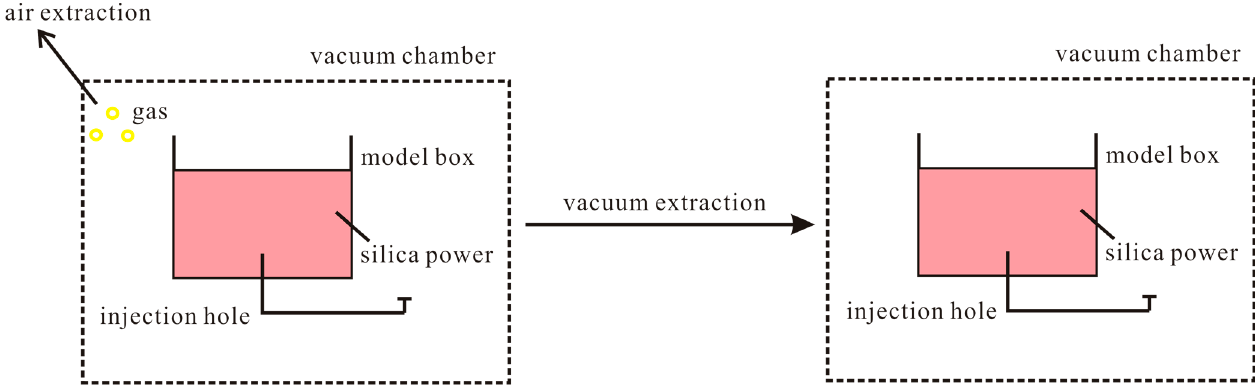
Figure 5. Schematic diagram of vacuum extraction.